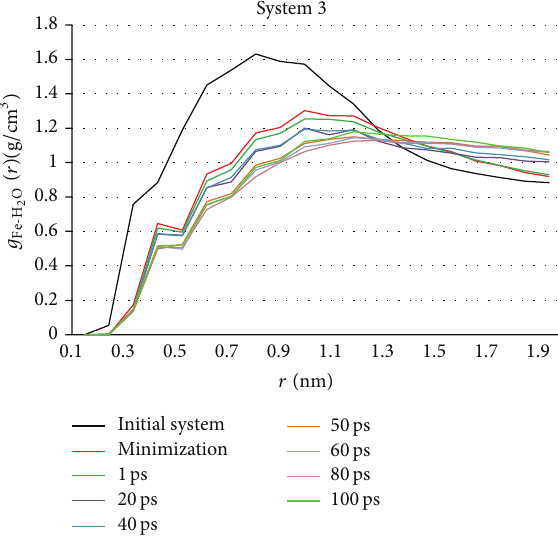
Figure 8: Curves of total energy in systems 1–5.